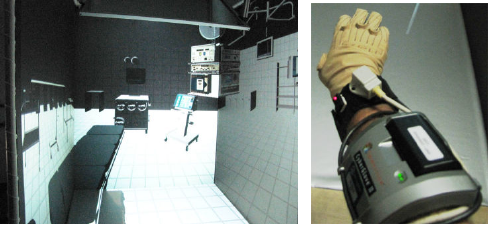
Figure 6. Virtual surgery room (left) and CyberGrasp Wireless II (right).